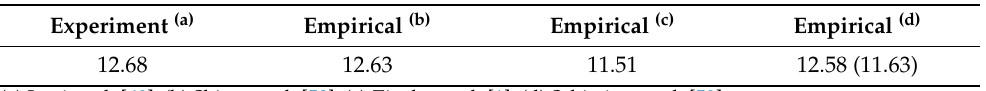
Table 1. Equilibrium charge of S ions (2 MeV/u) in carbon foils. The value in the parenthesis in the last column is for gas